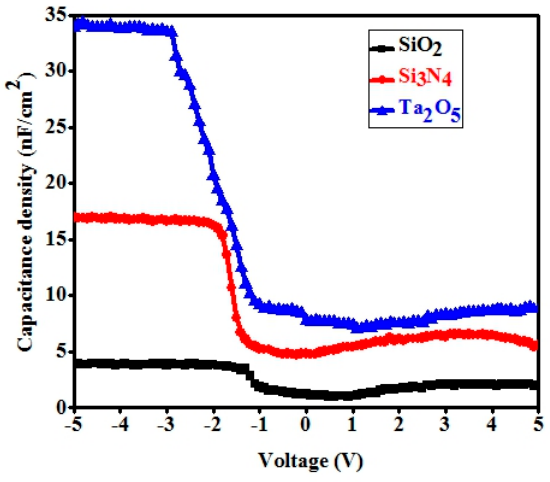
Figure 5. Capacitance density vs. voltage characteristics of the metal-insulator–semiconductor (MIS) capacitor with gate dielectric SiO 2 , Si 3 N 4 , and Ta 2 O 5 deposited on p + Si wafer.